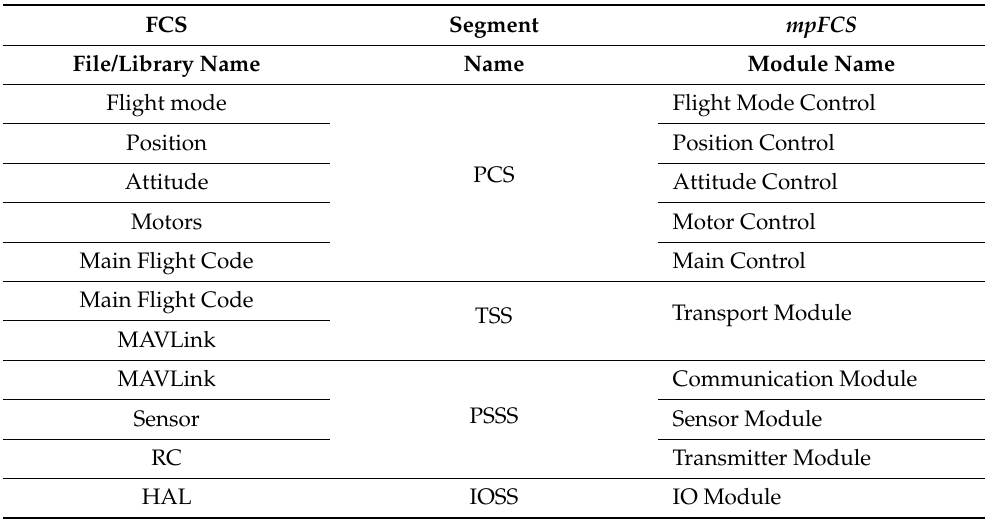
Table 4. Modules of flight control software and their matching of the FACE